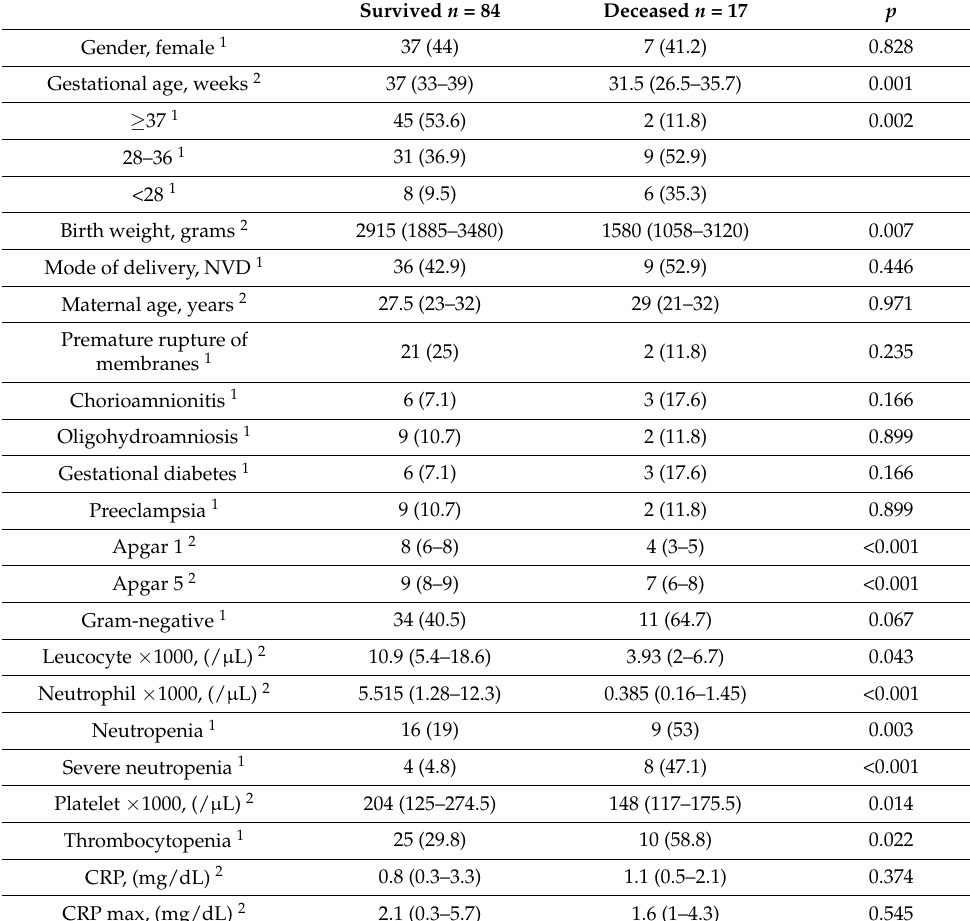
Table 5. Characteristics of survived and deceased newborns in early-onset